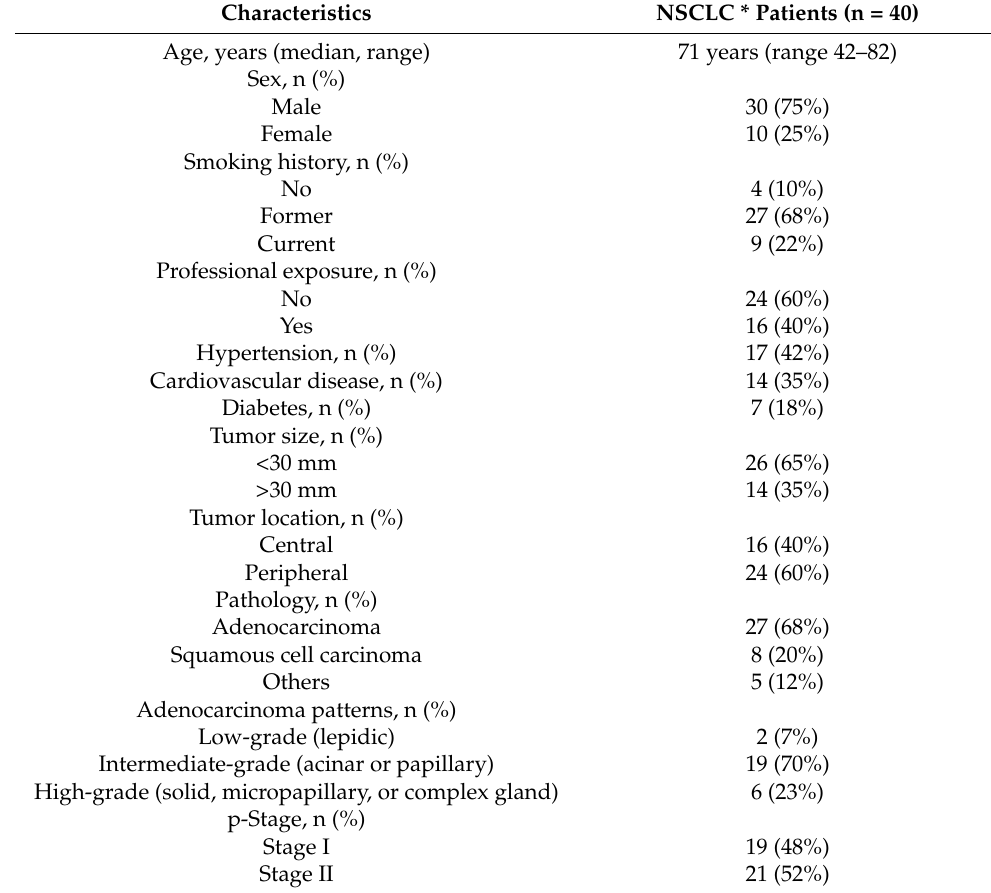
Table 1. Demographics and clinico-pathological characteristics of study